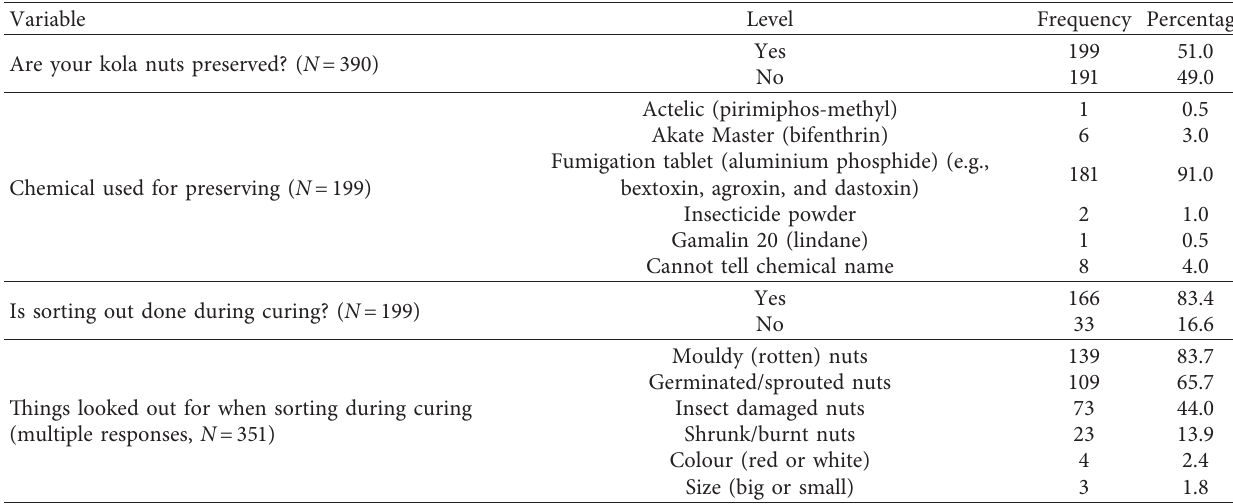
Table 10: Preservation of kola nuts during storage to increase shelf life before sales.